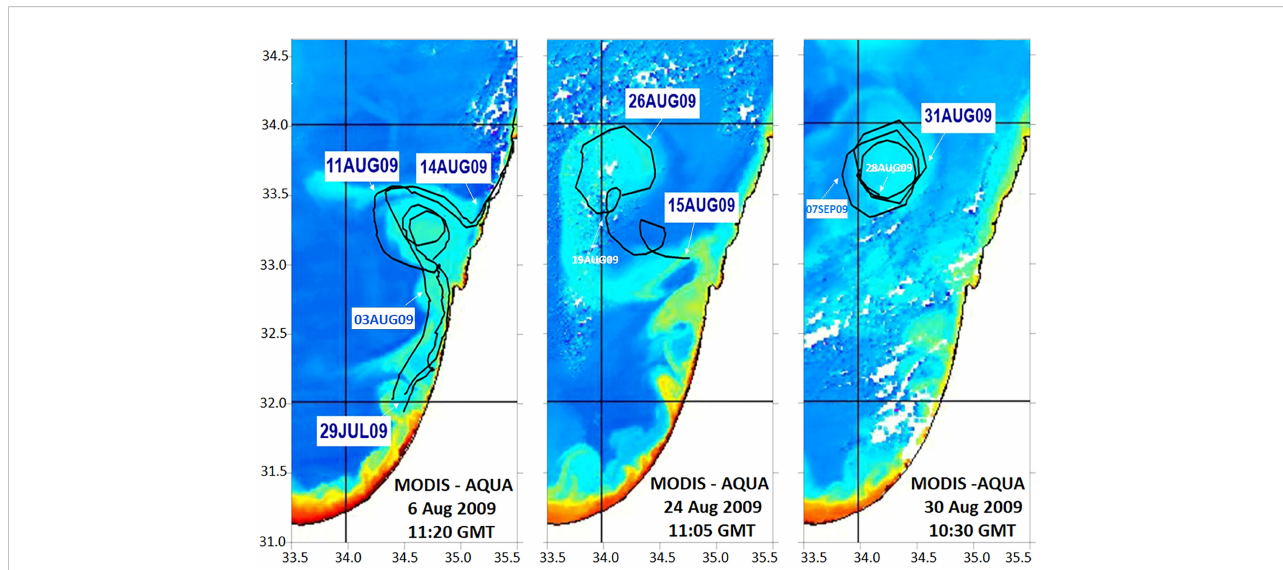
FIGURE 6 The NEMED SVP drifter trajectories superimposed on MODIS satellite images along the Israel-Lebanon shelf and slope from 29 Jul to 31 Aug 2009, showing the anticyclonic eddy formation starting as a meander in the northward fl owing shelf-slope current, detaching from the current as an anticyclonic eddy and drifting out to the open sea towards the northwest. This eddy was simultaneously observed during the summer CYBO 22 cruise in late August